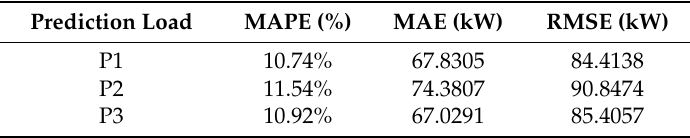
Table 5. Comparison between P1, P2, and P3.